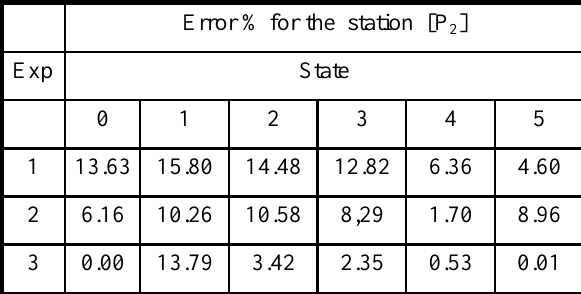
Table 3. Comparison of the second queue of the equivalent synchronization station Error % for the station [P 2